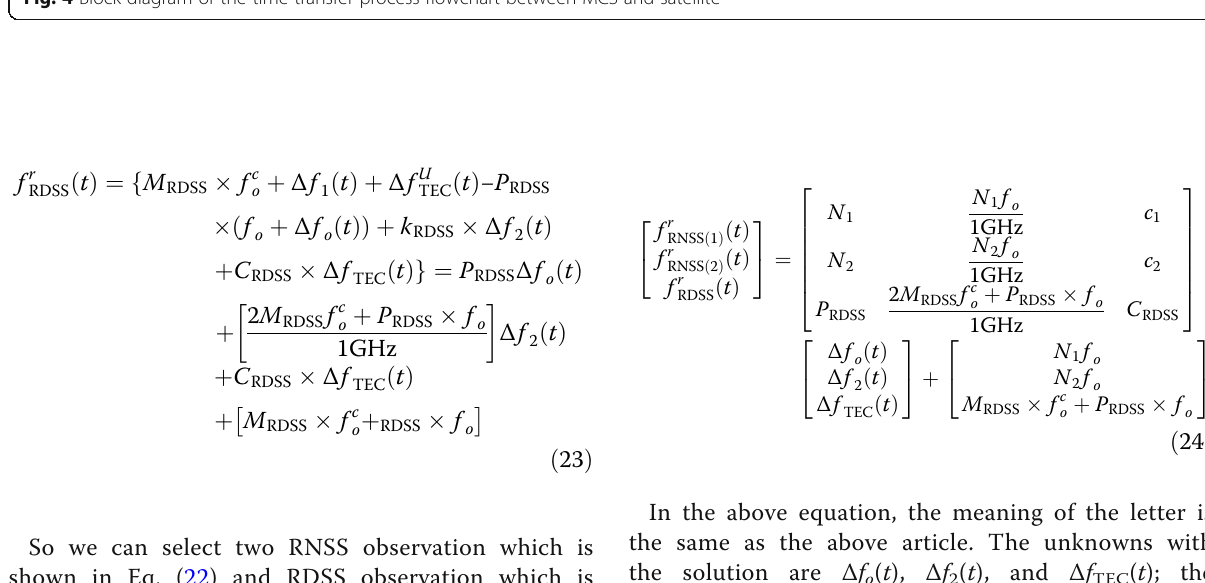
Fig. 4 Block diagram of the time transfer process flowchart between MCS and